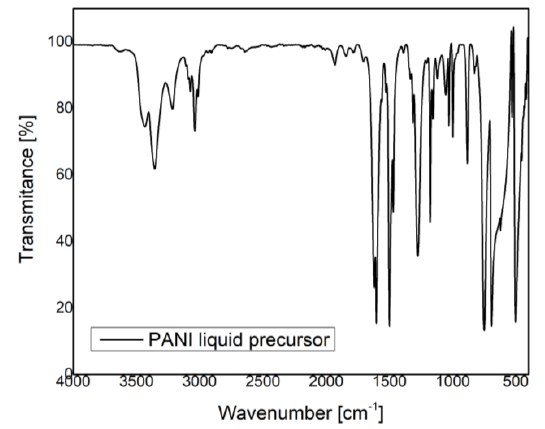
Figure 6. FTIR spectra of PANI liquid precursor.